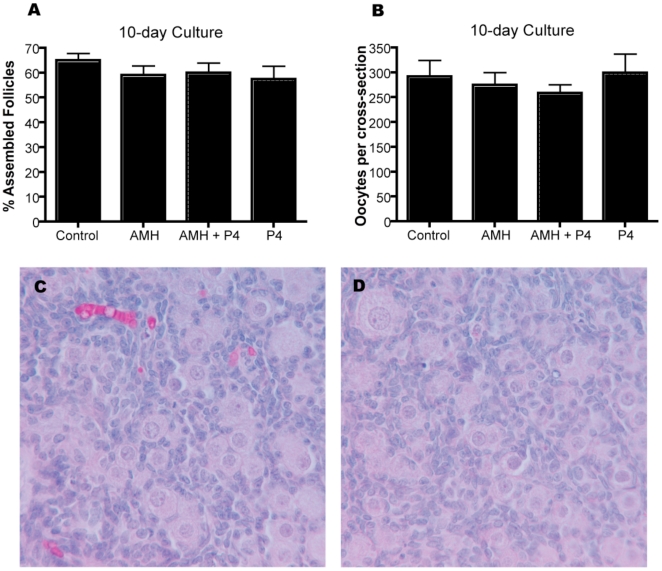
Primordial follicle pool size and percentage of assembled follicles as determined by oocyte counts per cross section after 10 days of treatment with AMH, progesterone (P4) and AMH combined with P4.The mean ±SEM for a minimum of three experiments in replicate performed. (A) Percent assembled follicles. (B) Total oocytes per cross-section. (C) Representative untreated control ovary section, H&E stained. (D) Representative AMH treated ovary section, H&E stained.